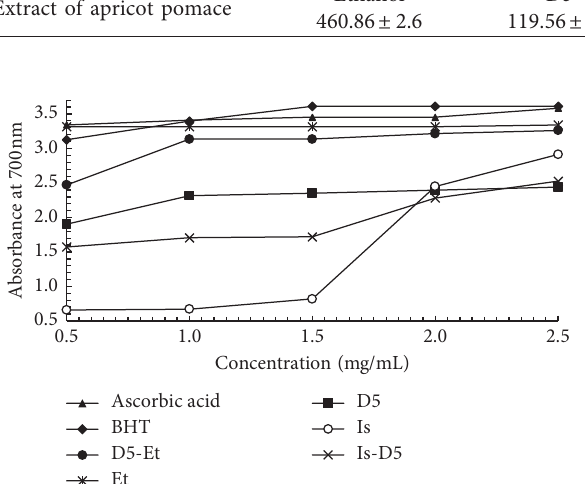
Table 4: The total antioxidant capacity of extracts obtained using various solvents. Plant extract